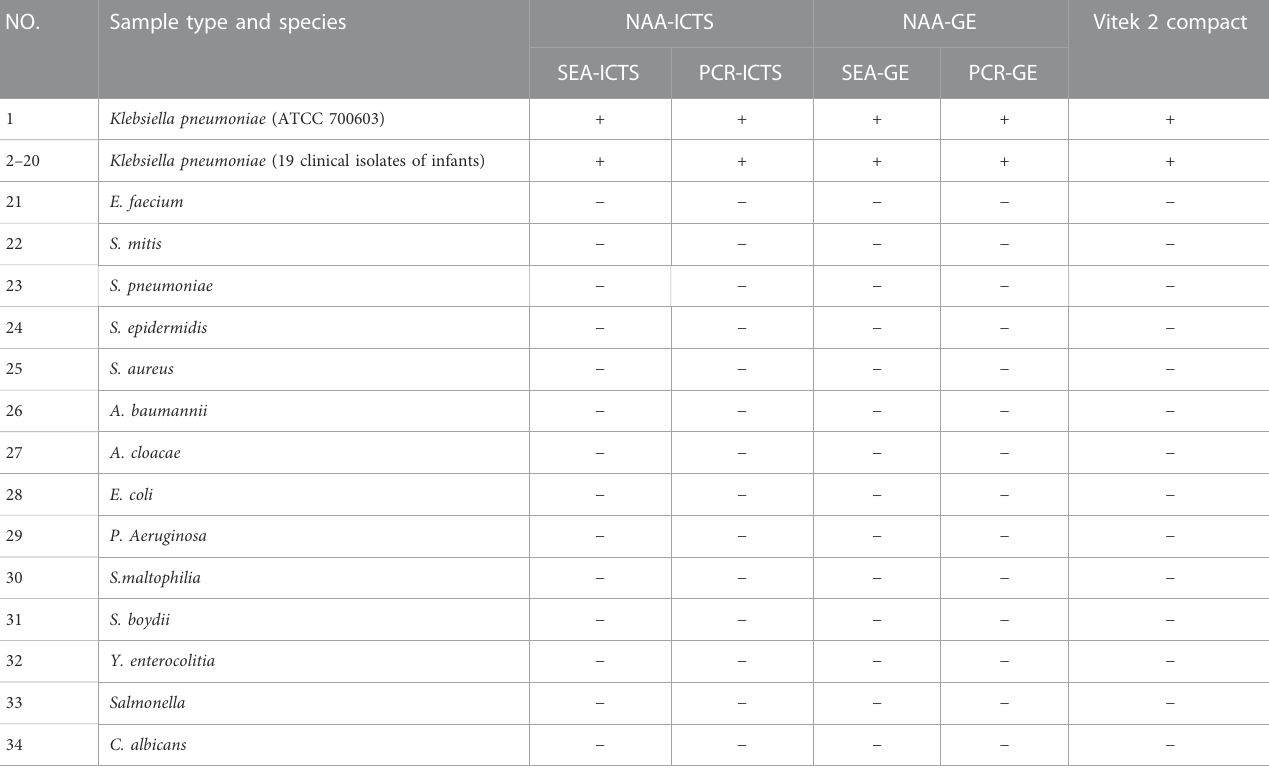
FIGURE 8 Speci fi city detection of Klebsiella pneumoniae . (A) Detection speci fi city of SEA-GE using Klebsiella pneumoniae ( mdh ) and non- Klebsiella pneumoniae : lane M, DL 500 DNA marker; lanes 1-2, Klebsiella pneumoniae with different DNA concentrations; lanes 3 – 16, non- Klebsiella pneumoniae, Lane 17, negative